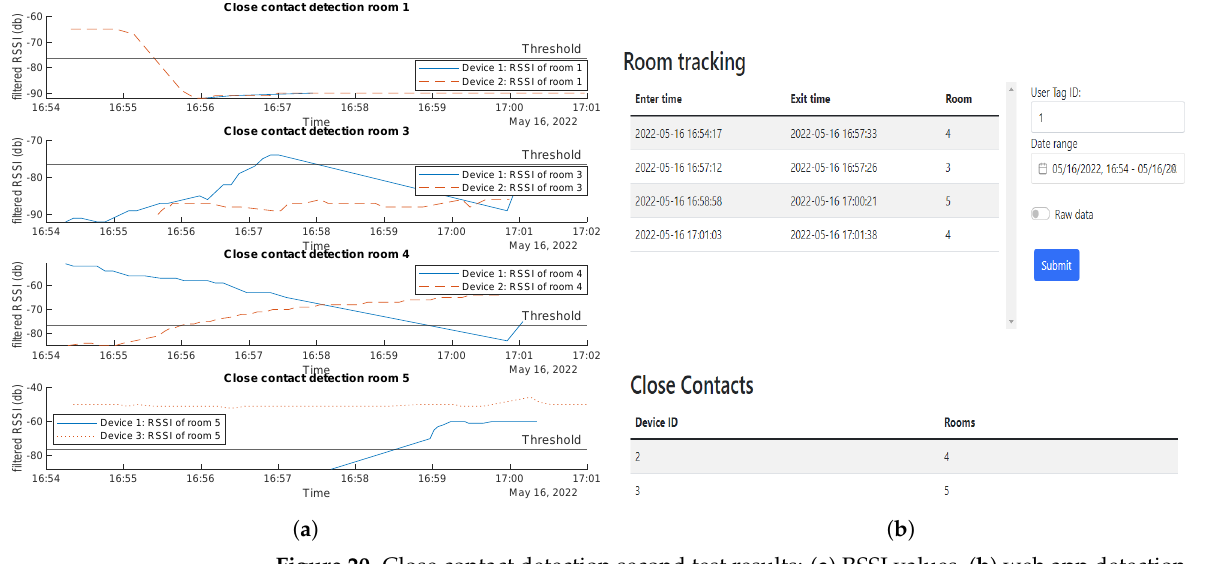
Figure 20. Close contact detection second test results: ( a ) RSSI values, ( b ) web app